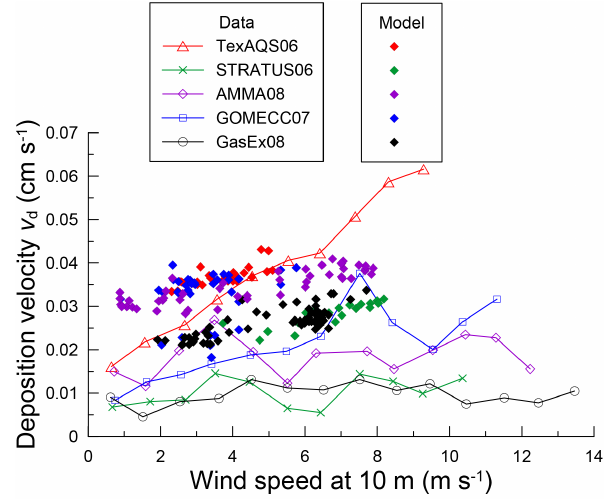
Figure 3. Ozone dry deposition velocity ( v d ) as a function of wind speed at 10m height from five field experiments (Helmig et al., 2012) and the corresponding values obtained from the ACCESS- UKCA model with the default parameterisation for ozone deposi- tion to the ocean.